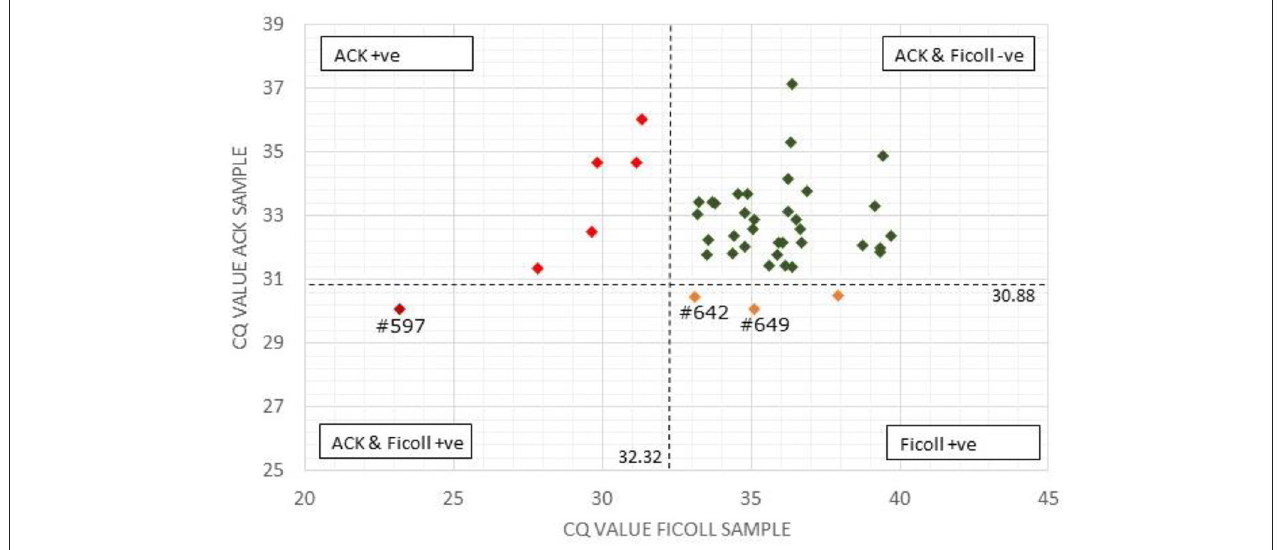
FIGURE 1 | Comparison of Actiphage pPCR test results using Ficoll and ACK methods to purify white blood cells. The Cq-values for the paired blood samples are compared using a scatter plot. Vertical and horizontal dashed lines are set at the cut off values for the Ficoll and ACK samples, respectively. Samples falling within each quadrant are colour coded and cut off values are given next to each line. The position of individual samples (#) referred to in the text are